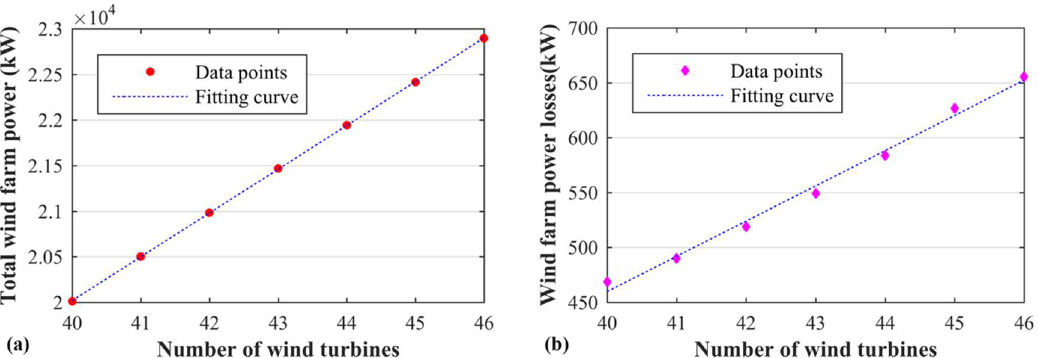
Figure 6. Probability of constant wind speed and variable wind directions.